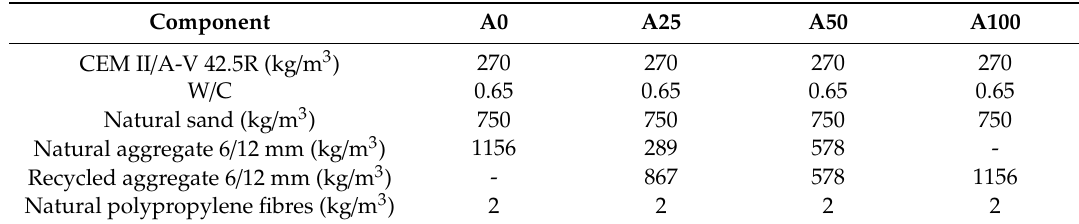
Table 2. Compositions of the tested concrete